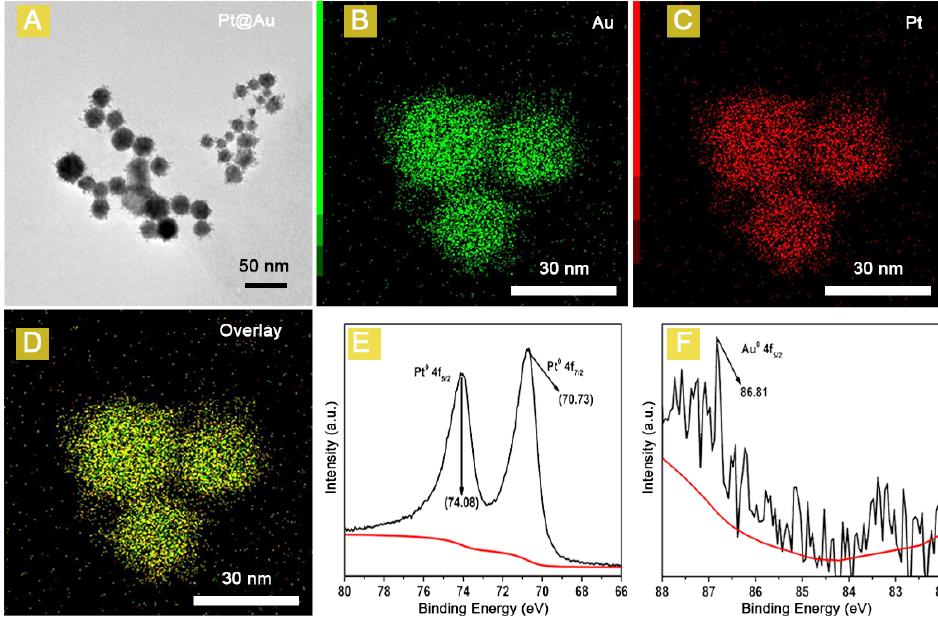
Figure 1. TEM images of Pt@Au ( A ); elemental mapping images of Au ( B ), Pt ( C ), and Au and Pt ( D ) in Pt@Au nanoparticles; and high-resolution XPS spectra of Pt4f ( E ) and Au4f ( F ).